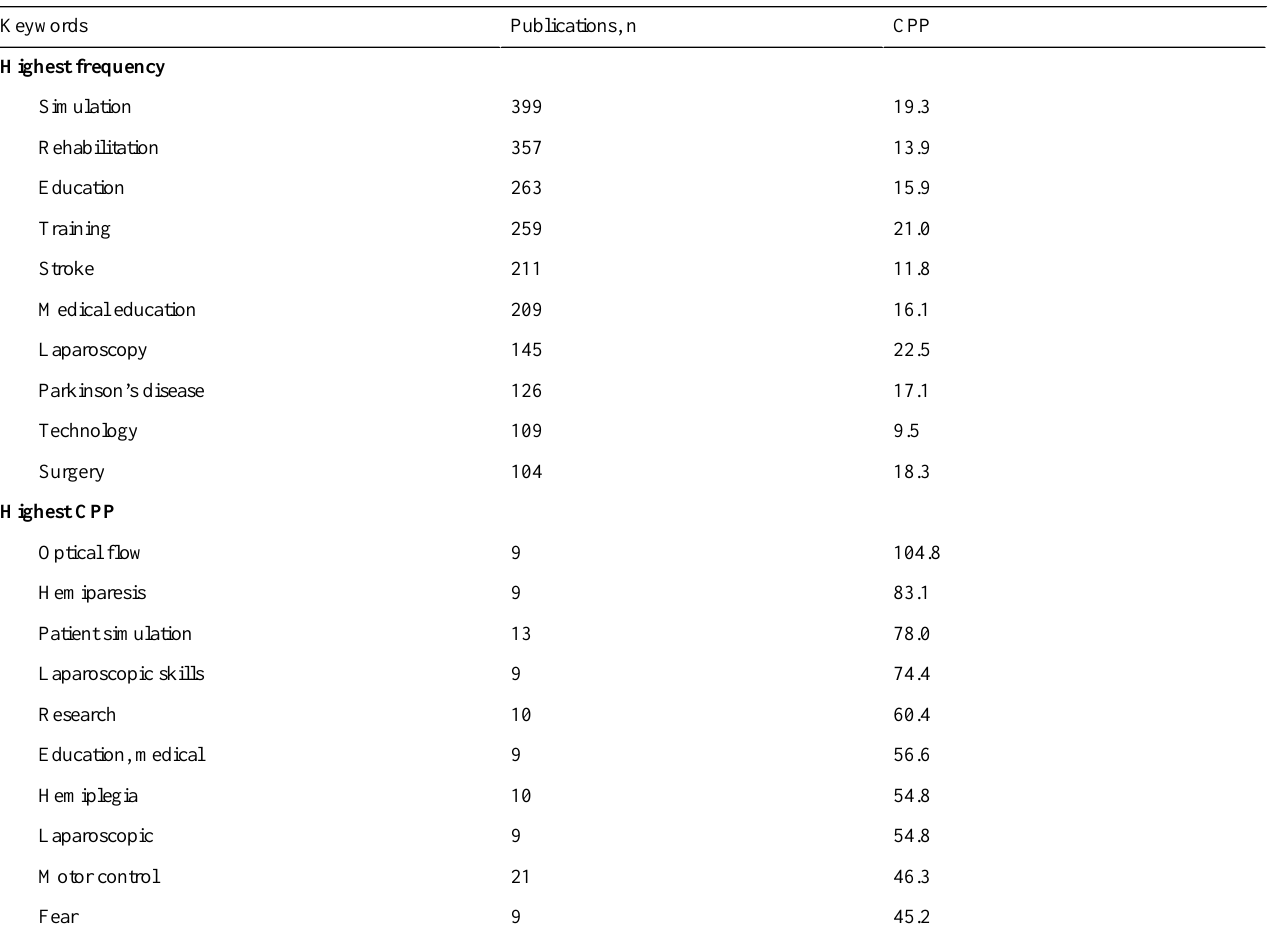
Table 6. The 10 author keywords with highest frequencies and citations per publication (CPPs; 8399